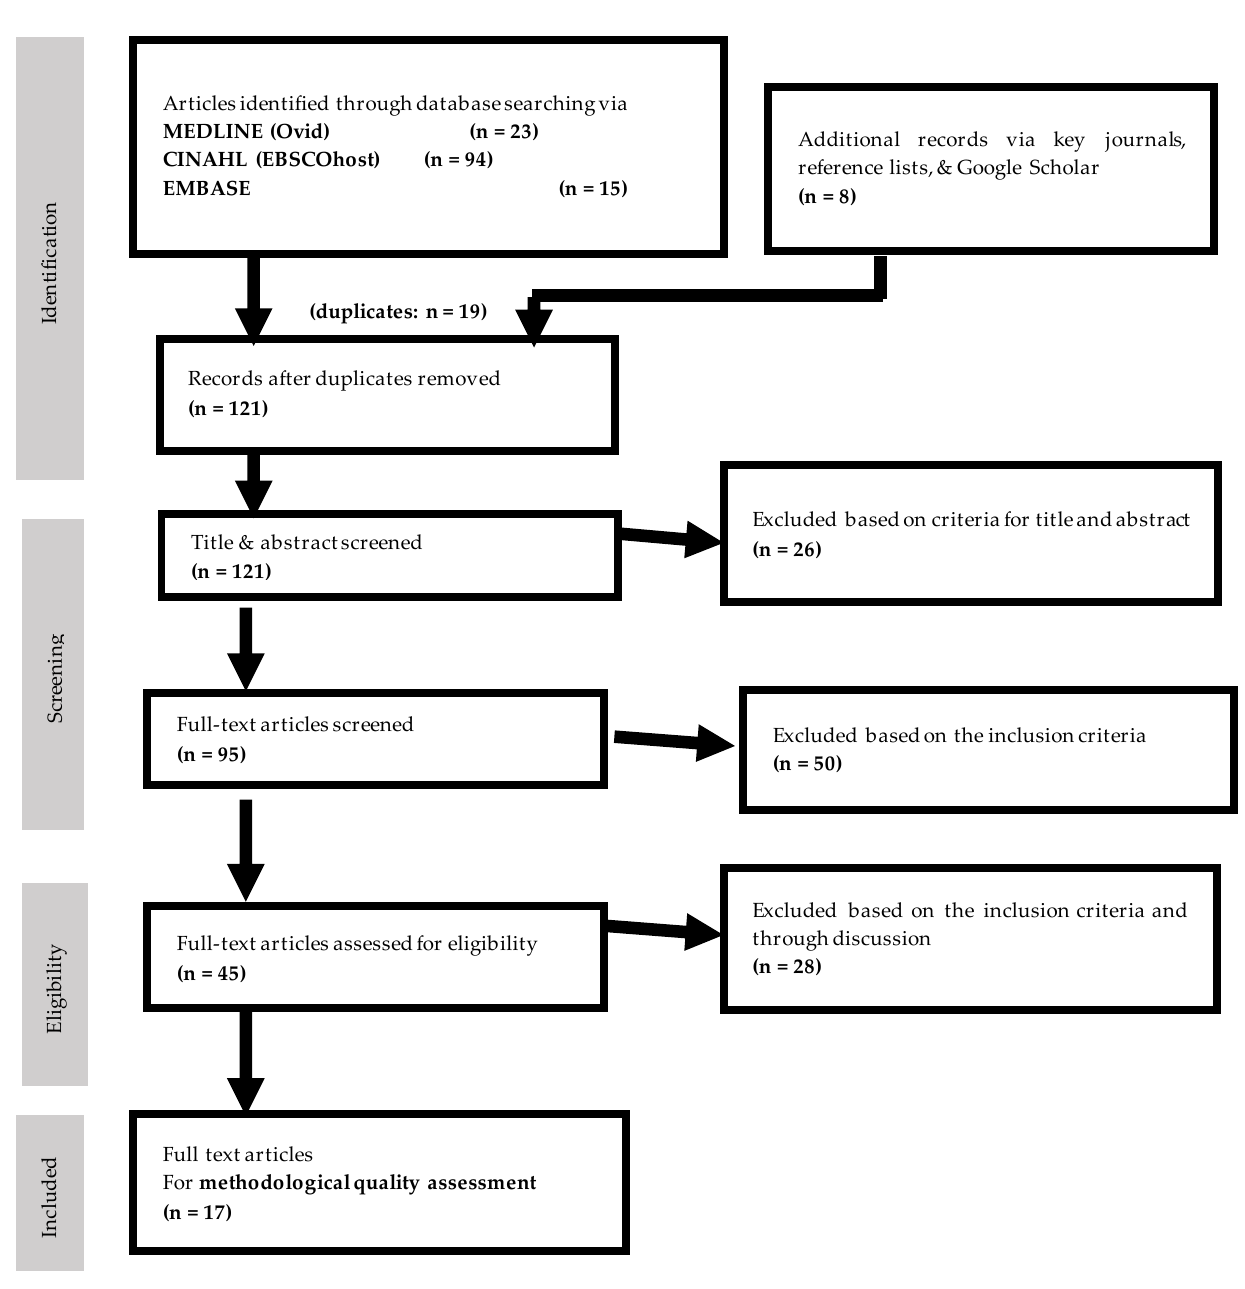
Figure 2. Flow of searching and inclusion of relevant articles.